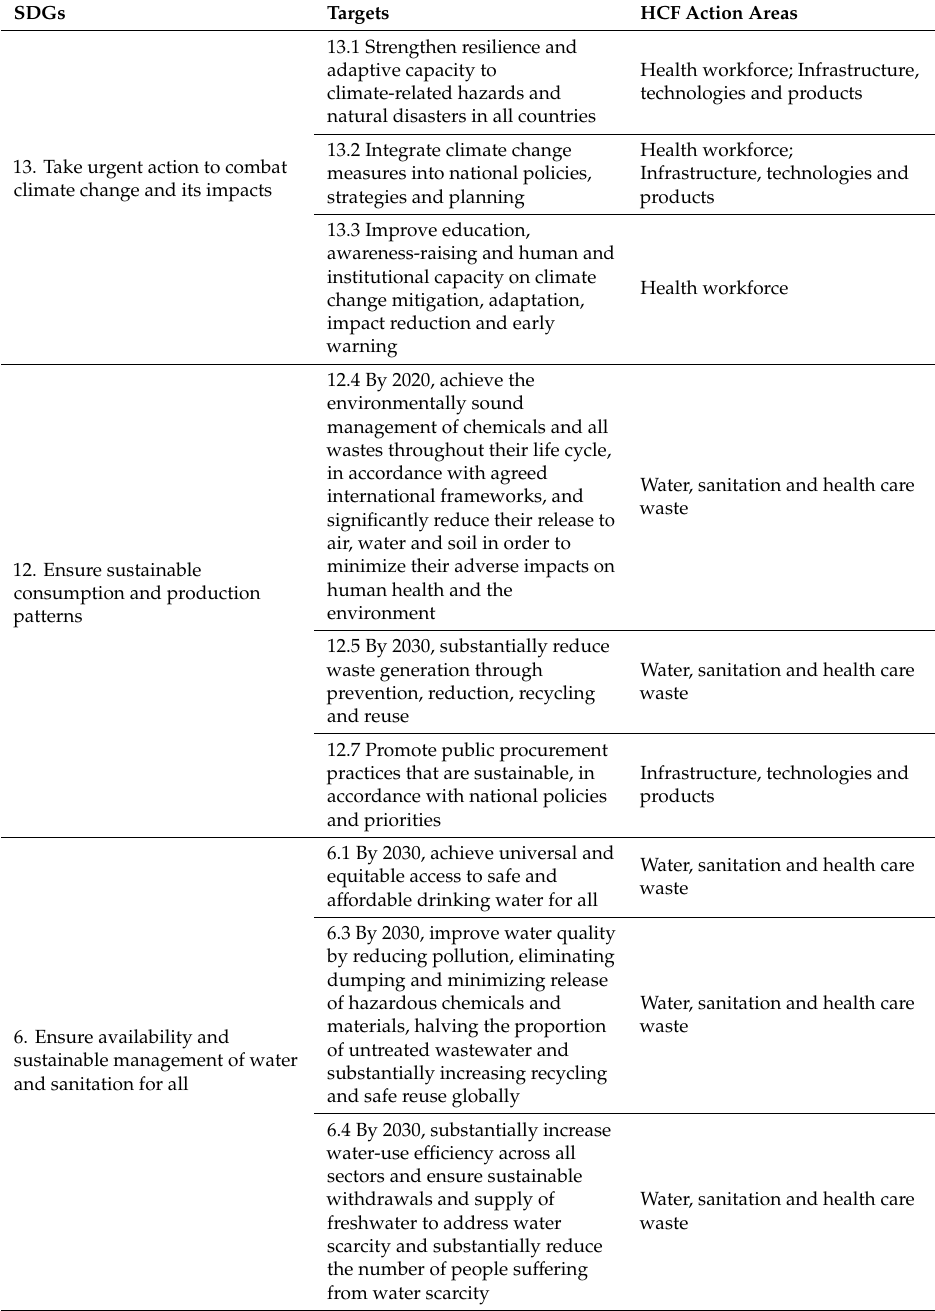
Table 1. Selected Sustainable Development Goals (SDGs) and targets with implications for health care